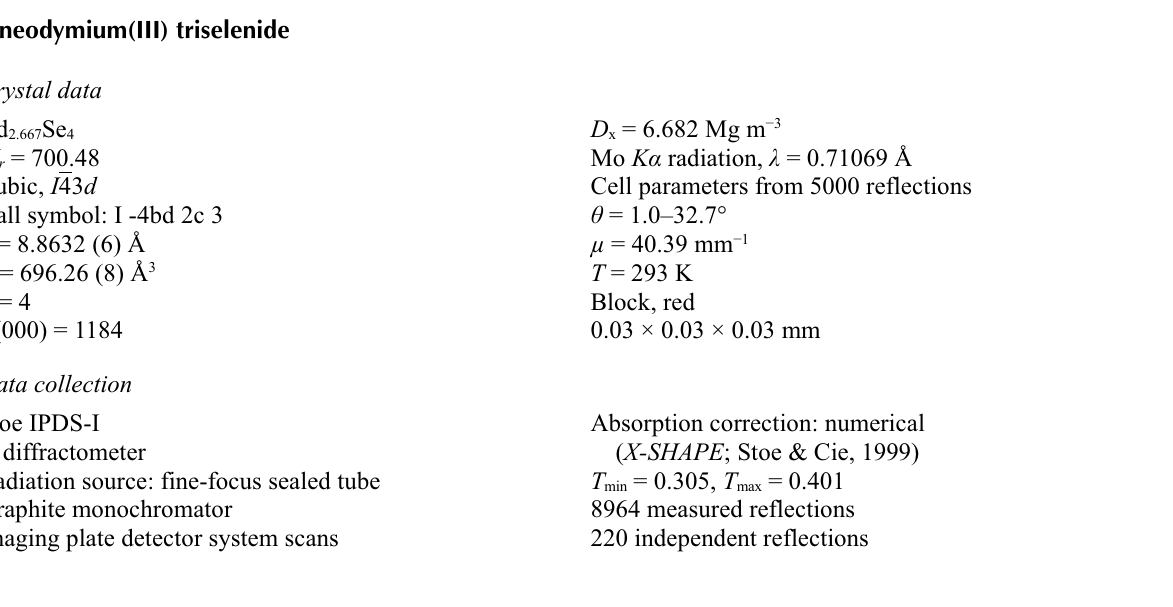
Coordination sphere of the Se 2- anion. Due to the under-occupation of the neodymium site, each selenium is surrounded by 5.333 Nd 3+ cations. Displacement ellipsoids are drawn at 95% probability level. [Symmetry codes: (viii) y , - z , - x + 1/2; (ix) - x + 1/2, - y , z - 1/2; ( x ) - y - 1/4, x - 1/4, - z + 1/4; (xi) y , z , x ; (xii) y + 1/4, - x + 3/4, - z +